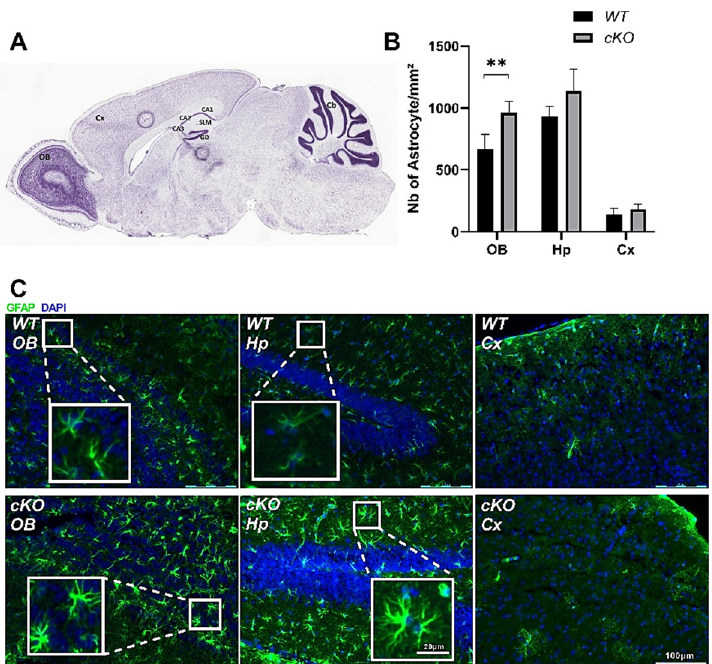
Figure 7. Astrocyte activation in astroglial Lsr in WT ( n = 5) and cKO ( n = 5) mice. ( A ) Sagittal brain section corresponding to the regions of interest. ( B ) Number of GFAP+ cells in different brain structures. Sagittal brain sections were stained with glial fibrillary acidic protein (GFAP). The measurements of the number of GFAP+ cells were the result of three sagittal sections analyzed per animal; the mean of all values represents one mouse. ( C ) Representative images from WT and cKO mice with GFAP staining (green) on sagittal sections counterstained with DAPI (nuclear blue staining). Scale bar 100 μ m. Each value represents the mean ± SEM (** p < 0.01). Abbreviations: OB, olfactory bulb; Cx, cortex; Hp, hippocampus; DG, dentate gyrus; CA, cornu ammonis; SLM, stratum lacunosum-moleculare.